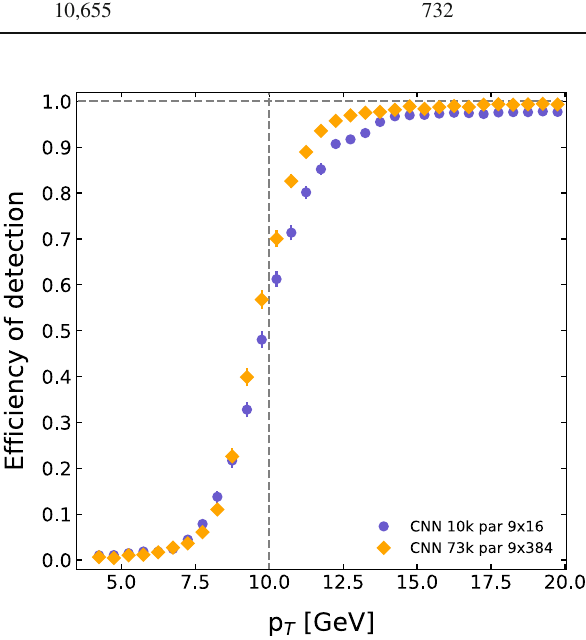
Figures9and10showtheresultofquantizationformodels with 4 and 3 bits per weight